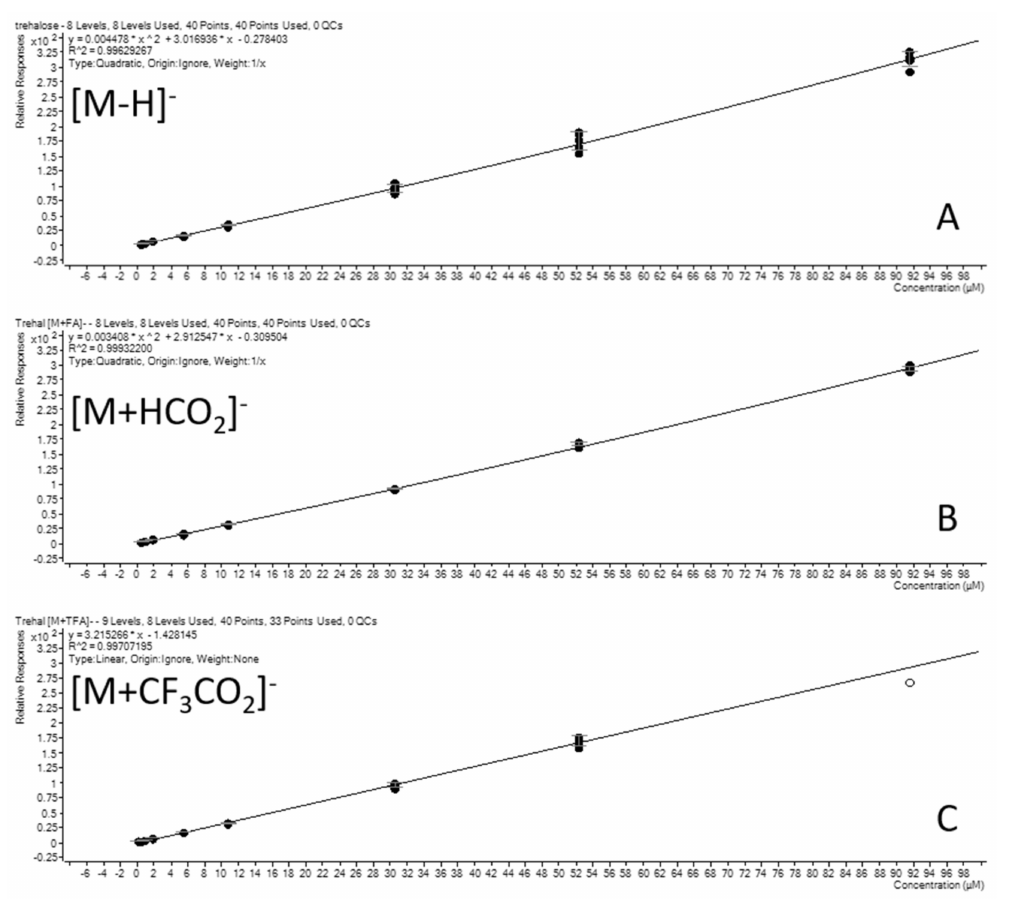
Figure 4. Calibration curve of trehalose monitored by ( A ): [M − H] − ; ( B ): [M − HCO 2 ] − ; ( C ): [M − CF 3 CO 2 ] − . Table 2. Reponses of trehalose at different concentrations ( µ M) for clusters [M − H] − ; [M − HCO 2 ] −